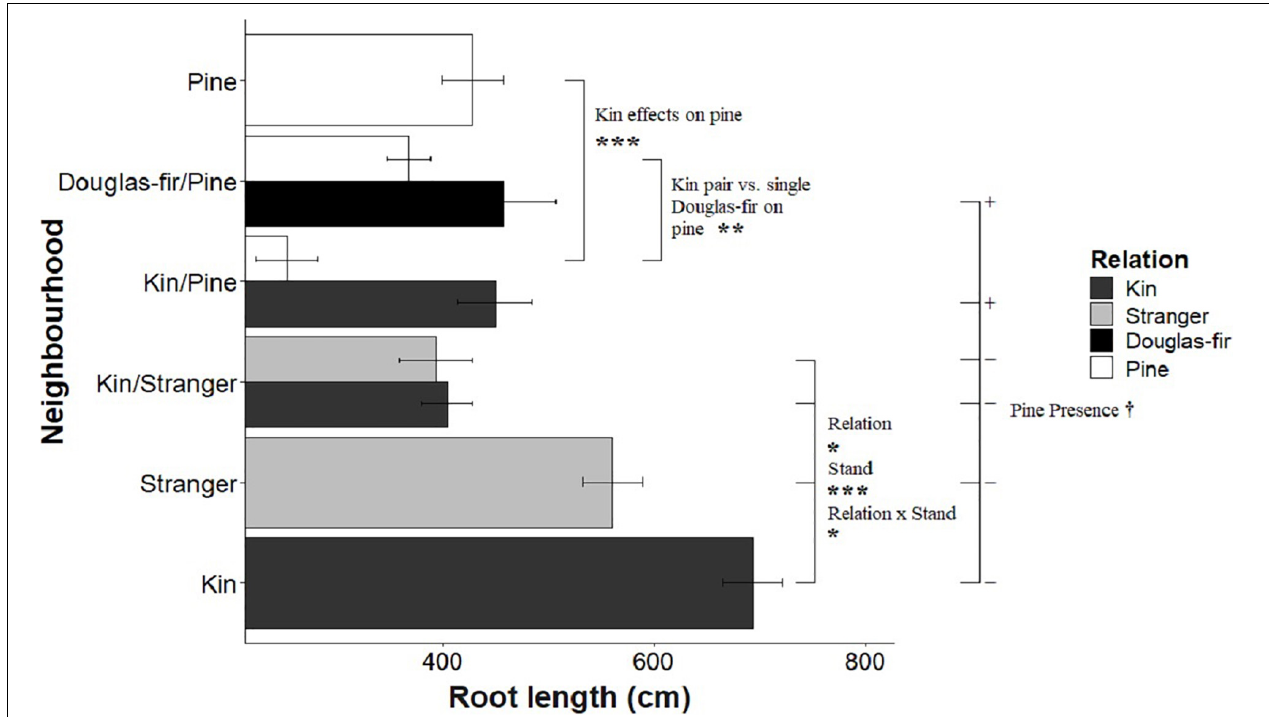
FIGURE 4 | The effect of neighborhood treatments on the root length for Douglas-fir seedlings (shaded) and pine seedlings (white). Significant planned contrasts are shown. Relation contrasted kin with stranger seedlings (estimate = –143, t ratio = –2.46, p = 0.0147, Df = 206). Stand contrasted seedlings grown in pure stand with those in mixed stands (estimate = 457, t ratio = 7.86, p < 0.0001, Df = 206). Relation × stand interaction was also significant (estimate = –122, t ratio = –2.11, p = 0.0363, Df = 206). The pine presence contrasted Douglas-fir seedlings grown with a pine neighbor vs. without a pine present in the pot (estimate = –118, t ratio = –1.77, p = 0.0780, Df = 206). Pine seedlings grown with a pairs of kin had less biomass than those grown in pairs of pine with a single Douglas-fir and less than pine grown in pure pine stands. * p < 0.05, ** p < 0.01, *** p < 0.001, and † p <